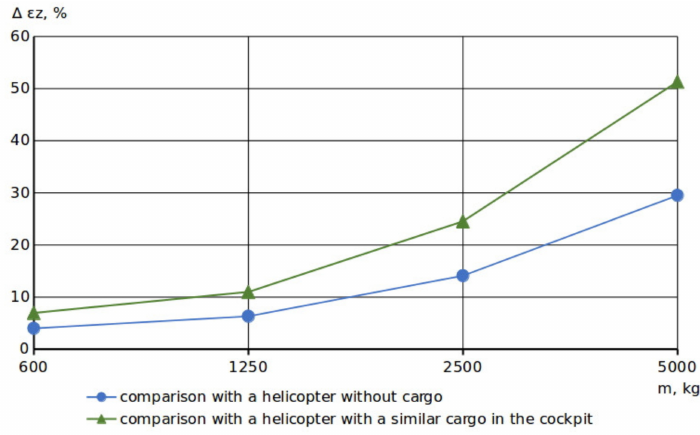
Figure 2. Influence of mass on-pitch angular acceleration.